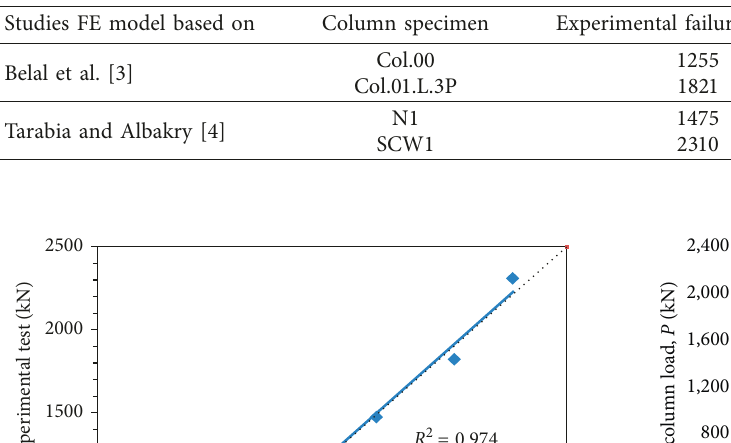
/ P for experimental and FE results. Exp FE